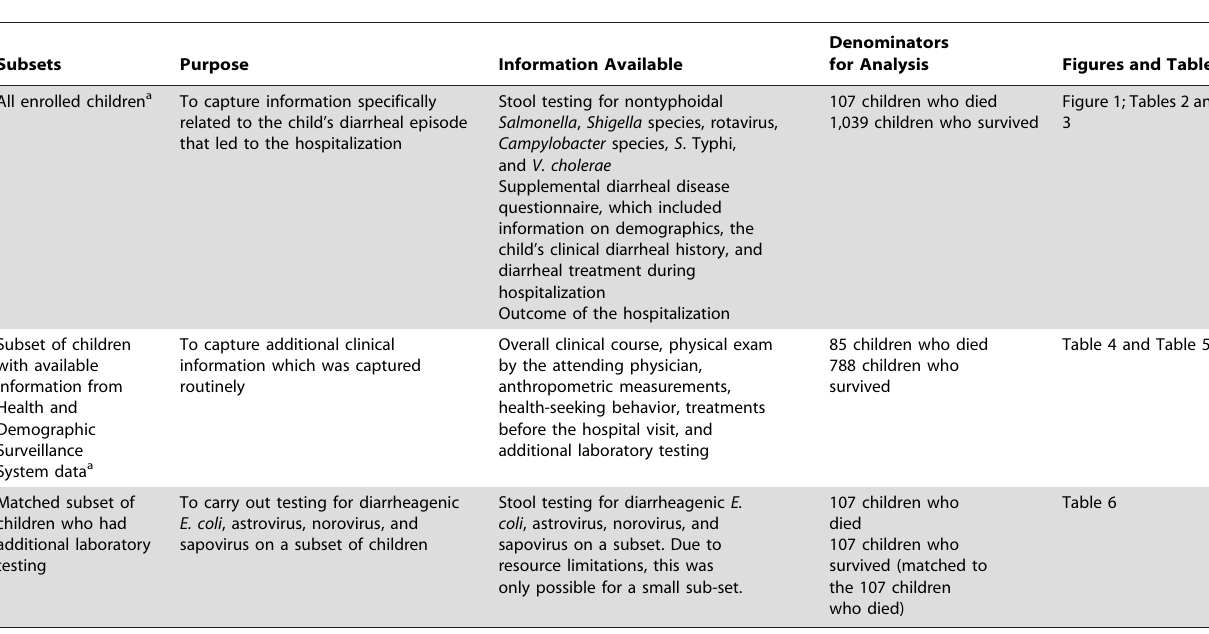
Table 1. List of the data collected for each of the subsets, and the associated denominators.